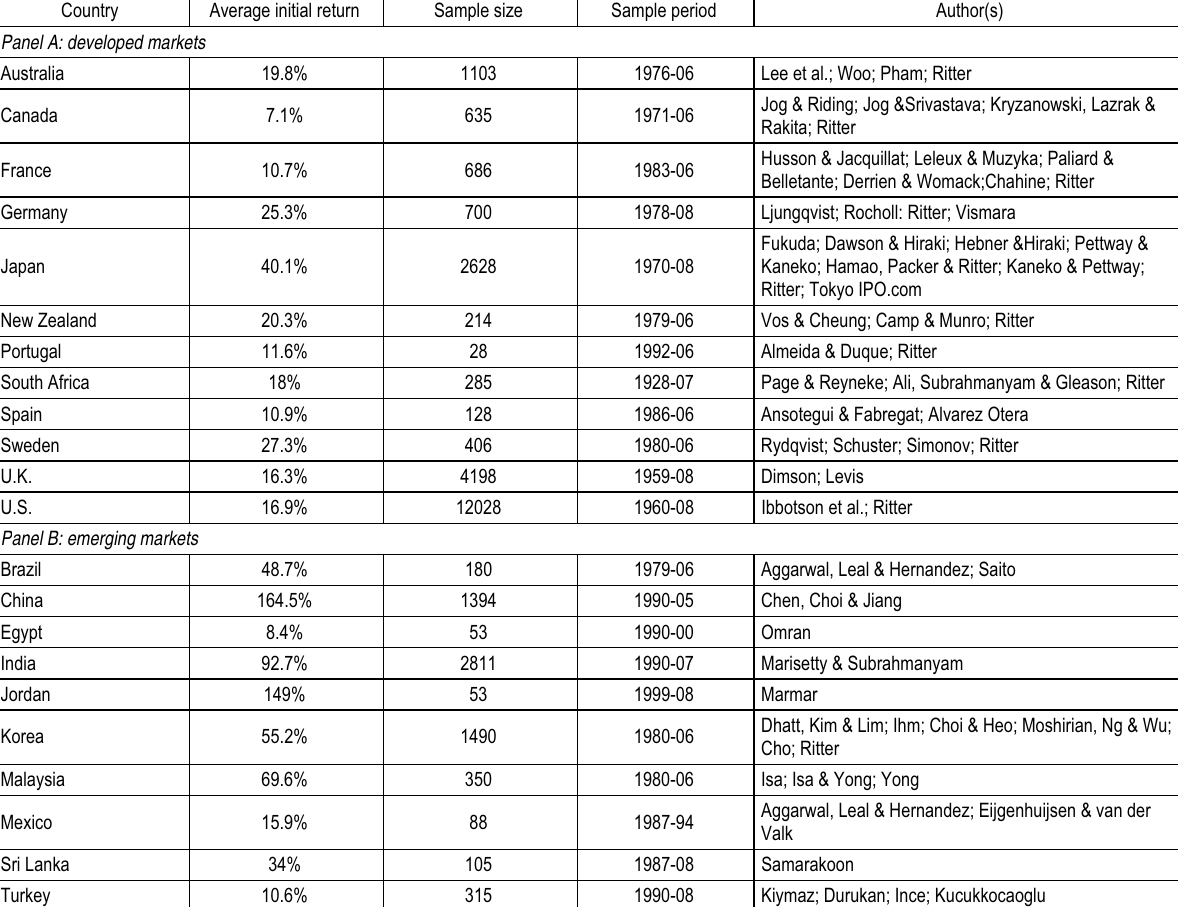
Table 1. Average first-day returns of IPOs in selected developed and emerging markets